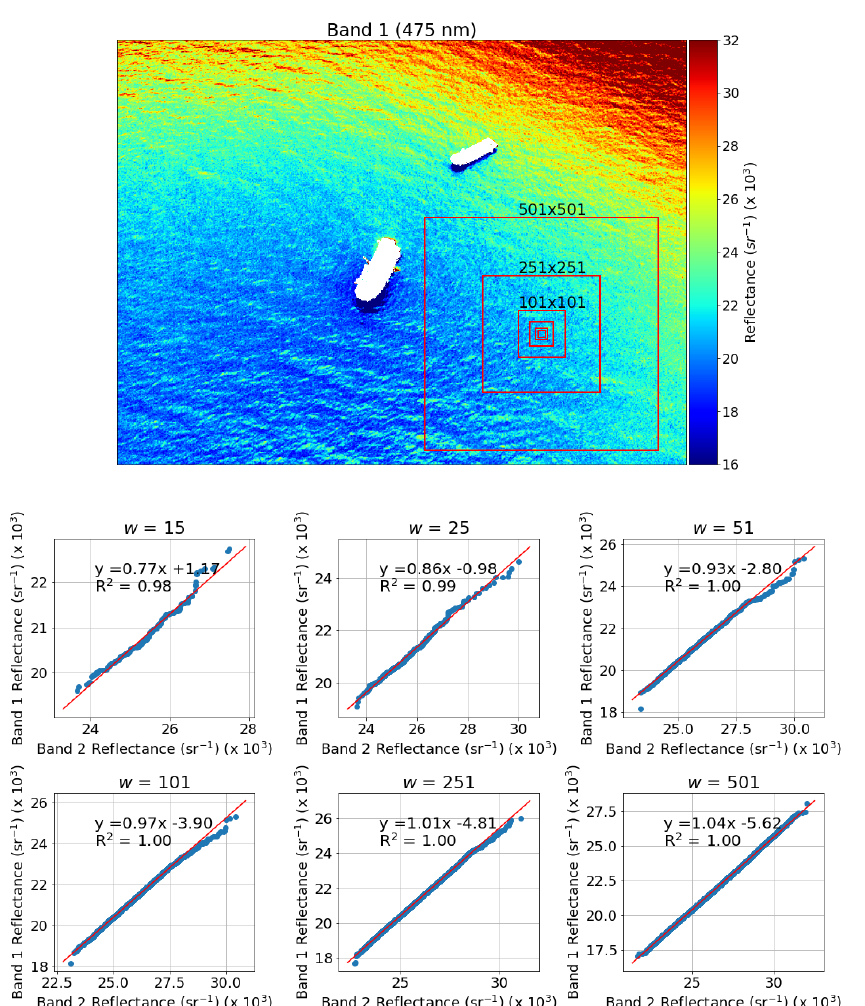
Figure 11. Regression results for varying sizes of the QQ plot calculation window. The extent of each window is marked in the corrected Band 1 image.